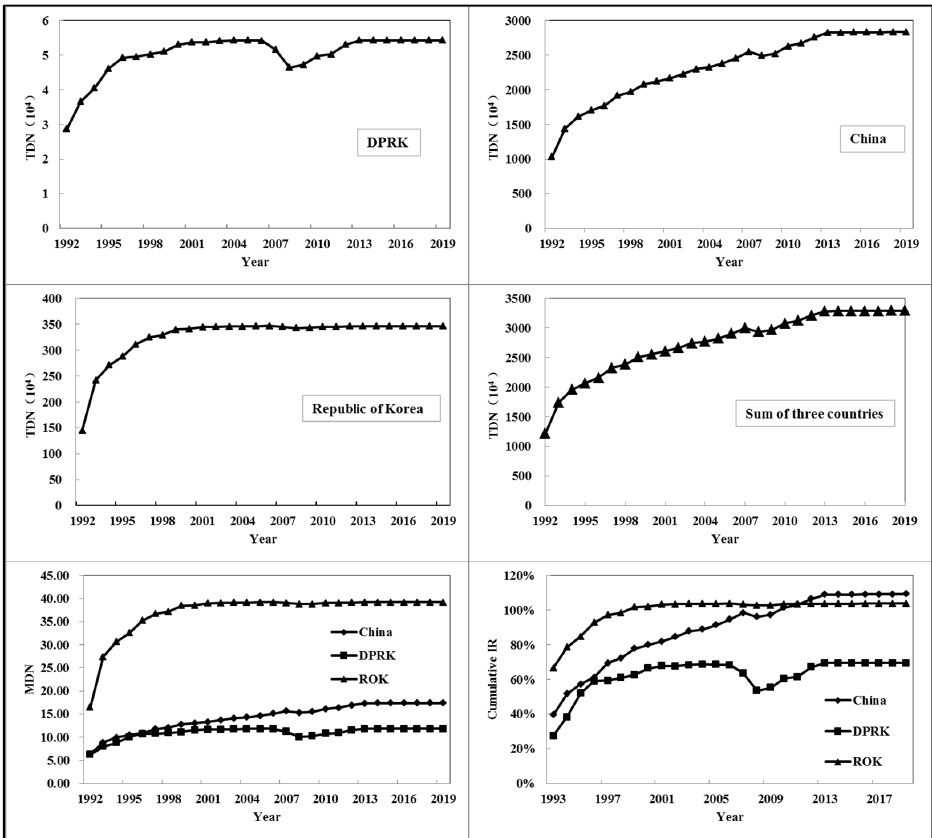
Figure 3. Variation of TDN , MDN , and IR in DPRK, China, and